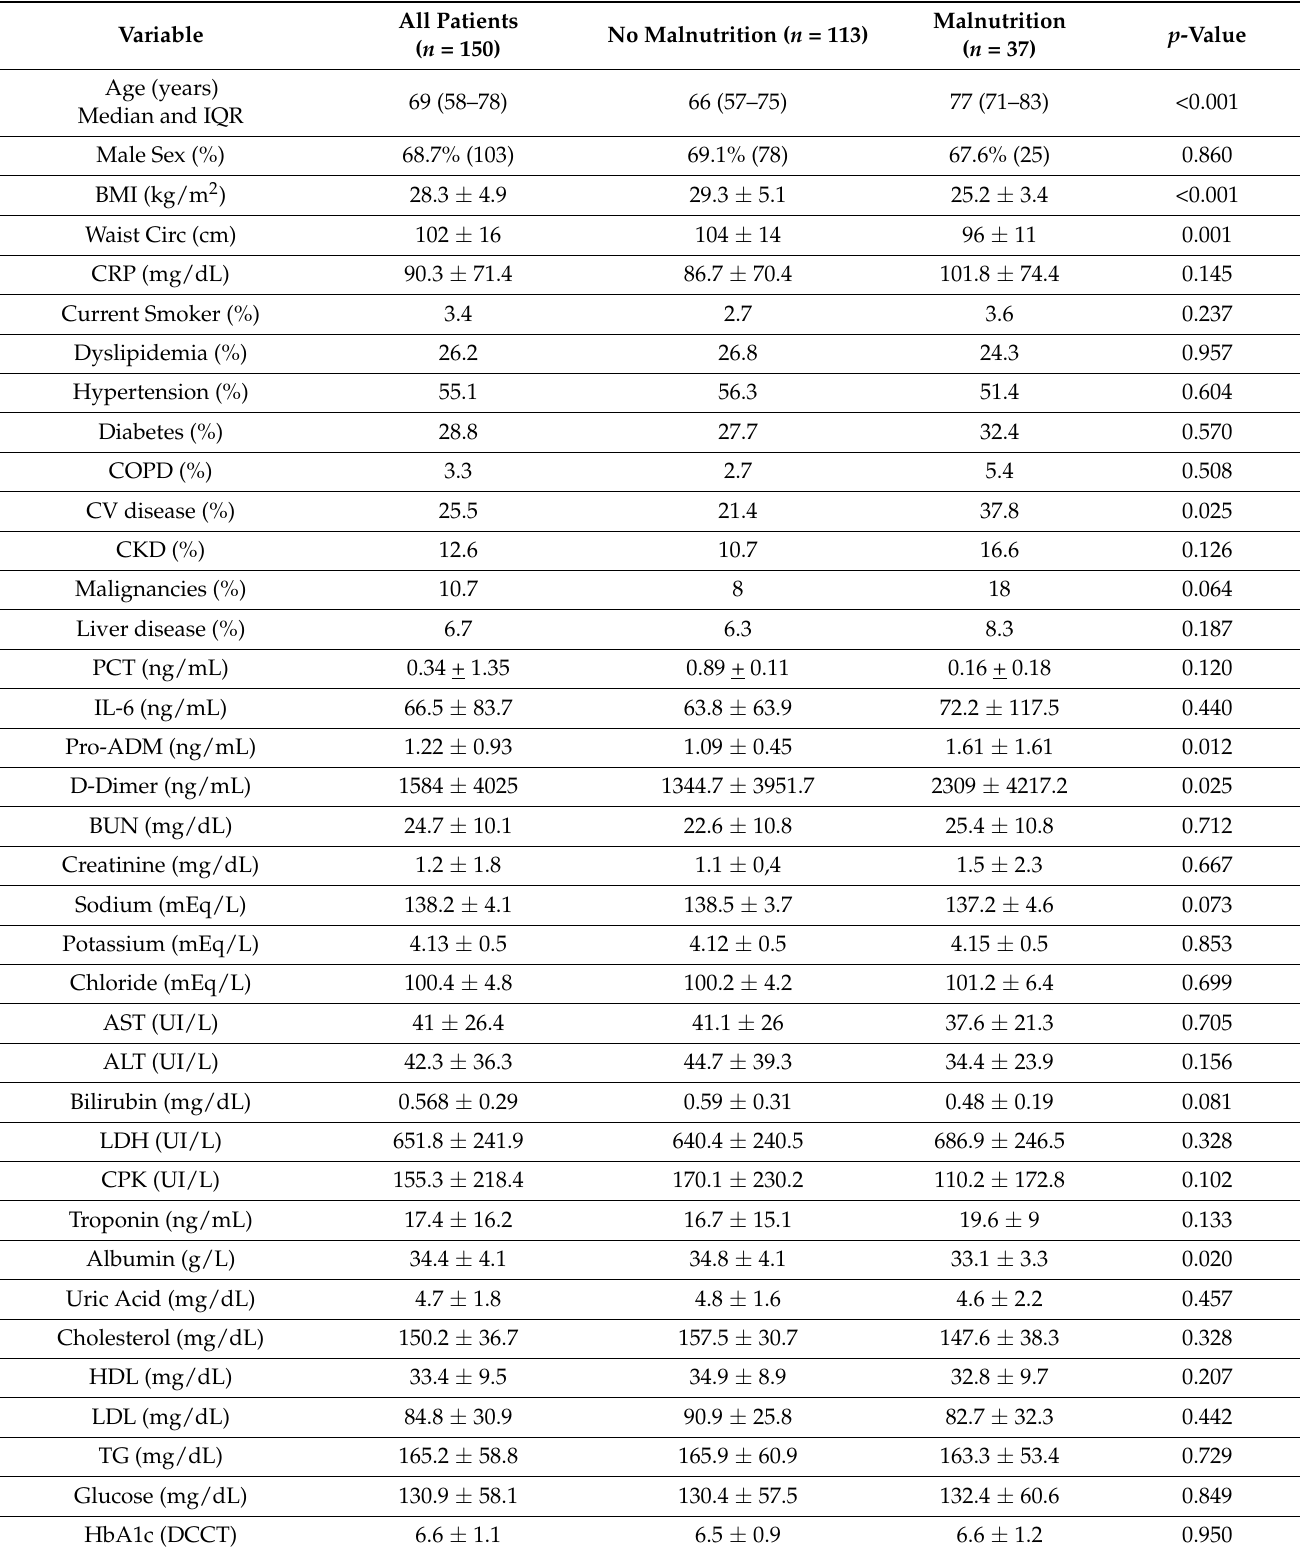
Table 1. Baseline clinical characteristics and laboratory